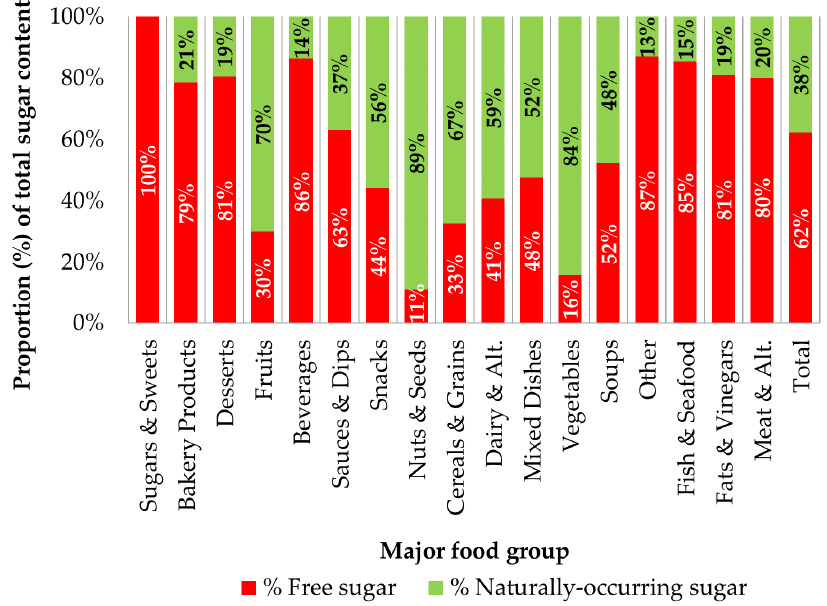
Figure 3. Free sugar and naturally ‐ occurring sugar as a proportion (%) of total sugar by major food group and overall ( n = 15,259). Free sugar and naturally ‐ occurring sugar as a percent of total sugar was calculated for each product and the average of those results is presented here.